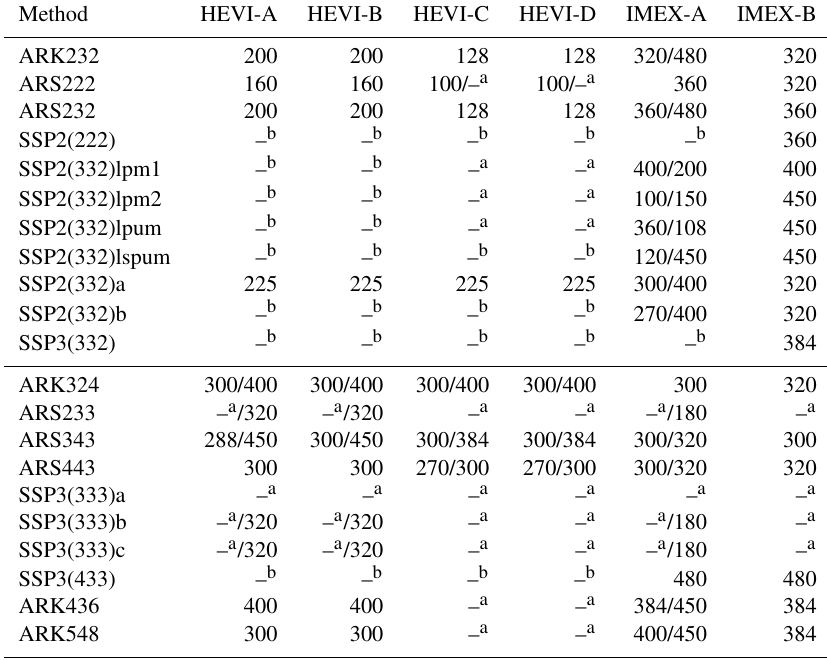
Table 2. Approximate largest step size (in seconds) for a 30-day run of the baroclinic wave test that produces acceptable maximum vertical velocities over time. Second-order methods are shown in the top section of the table and higher-order methods in the bottom section. For entries separated by “/”, the left value is the step size for the Rosenbrock-like approach and the right value is the step size for the Newton solver. When a single step size is given, the Rosenbrock-like and Newton solvers gave acceptable solutions at the same step